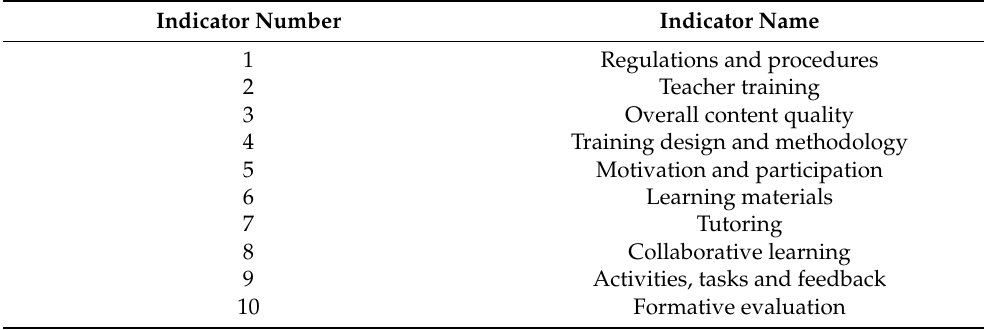
Table 1. Selected indicators of the SULODITOOL ® instrument for the analysis of the supervision of virtual teaching in non-university educational